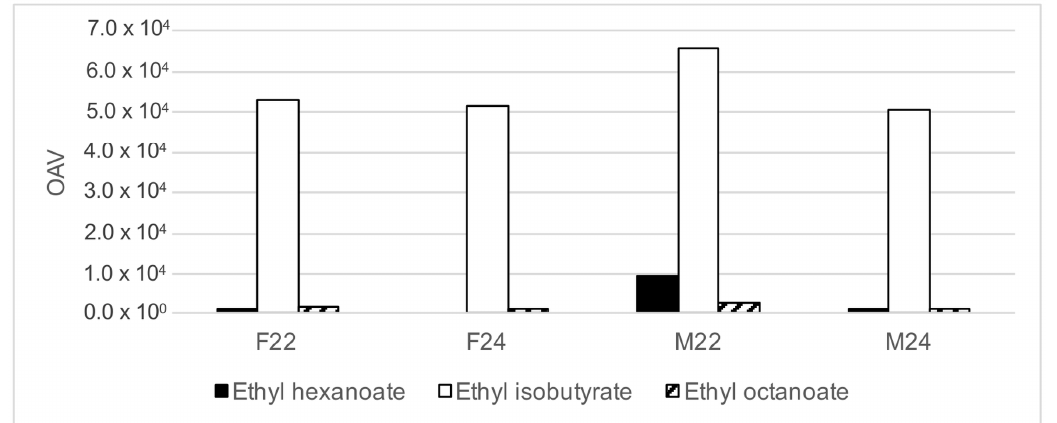
Figure 9. Odor (aroma) activity values of target analytes in headspace of Marquette and Frontenac wines made from berries harvested at 22° and 24° Brix. Odor detection thresholds for each analyte in water (and wine when available) from Leffingwell and Associates [33] were used to calculate OAV. OAV is the ratio of analyte concentration to its odor detection threshold. Ethyl octanoate is the dominate aroma compound present in headspace of Marquette and Frontenac wine samples (excluding alcohol), followed by ethyl hexanoate and ethyl octanoate. These compounds impart fruity